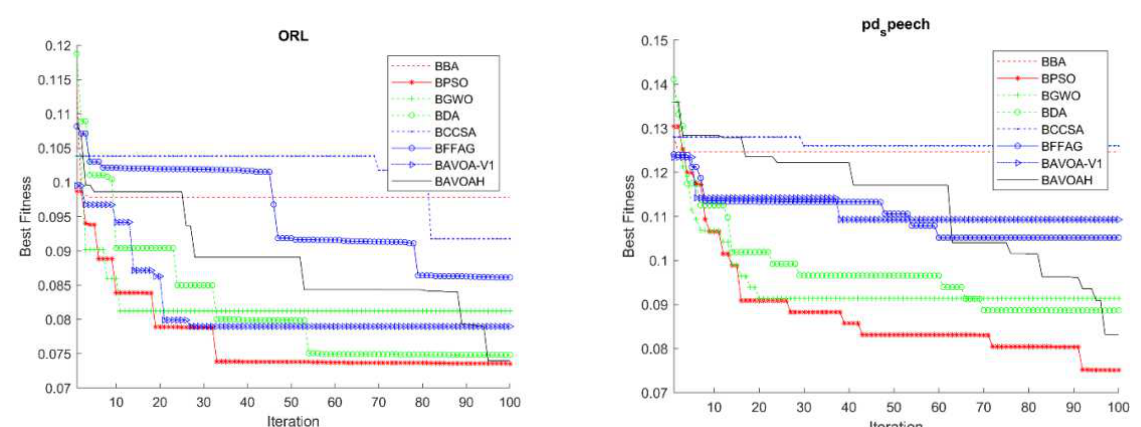
Figure 17. Comparison of the degree of convergence of the proposed BAOVAH (hyper-heuristic) and BAVOA-V1 (multi-strategy) method on the third six sets.